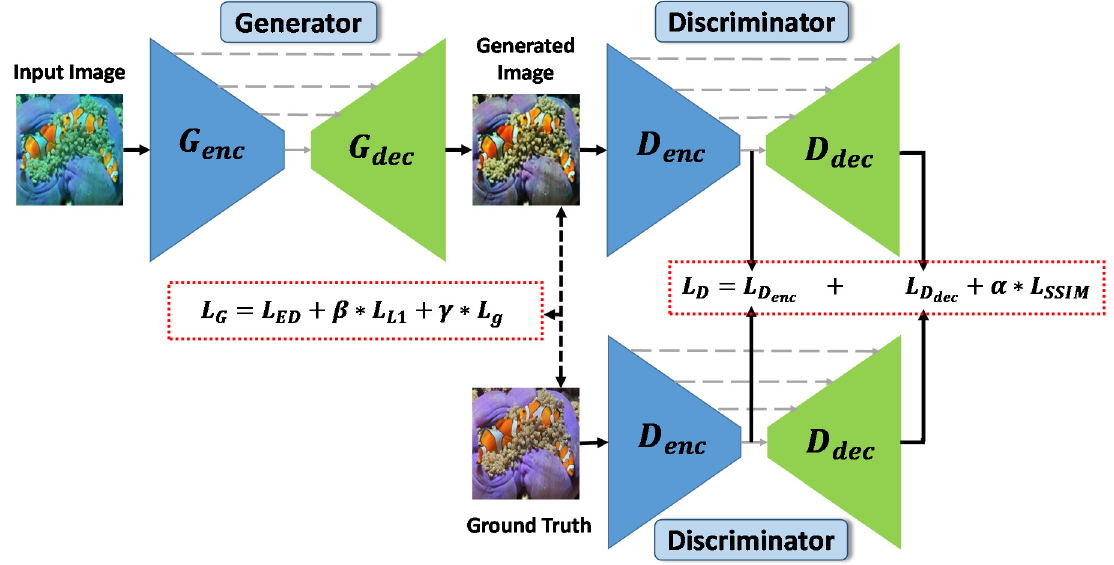
Figure 1. Overview of proposed DGAN architecture. The elements of the generator are shown in Figure 2 and the elements of the discriminator are shown in Figure 3.